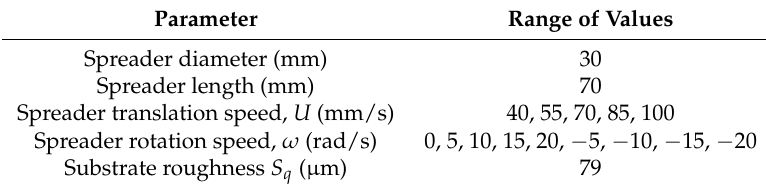
Table 1. Design of Simulations (DoS) for virtual spreading of polydispersed particulate media.